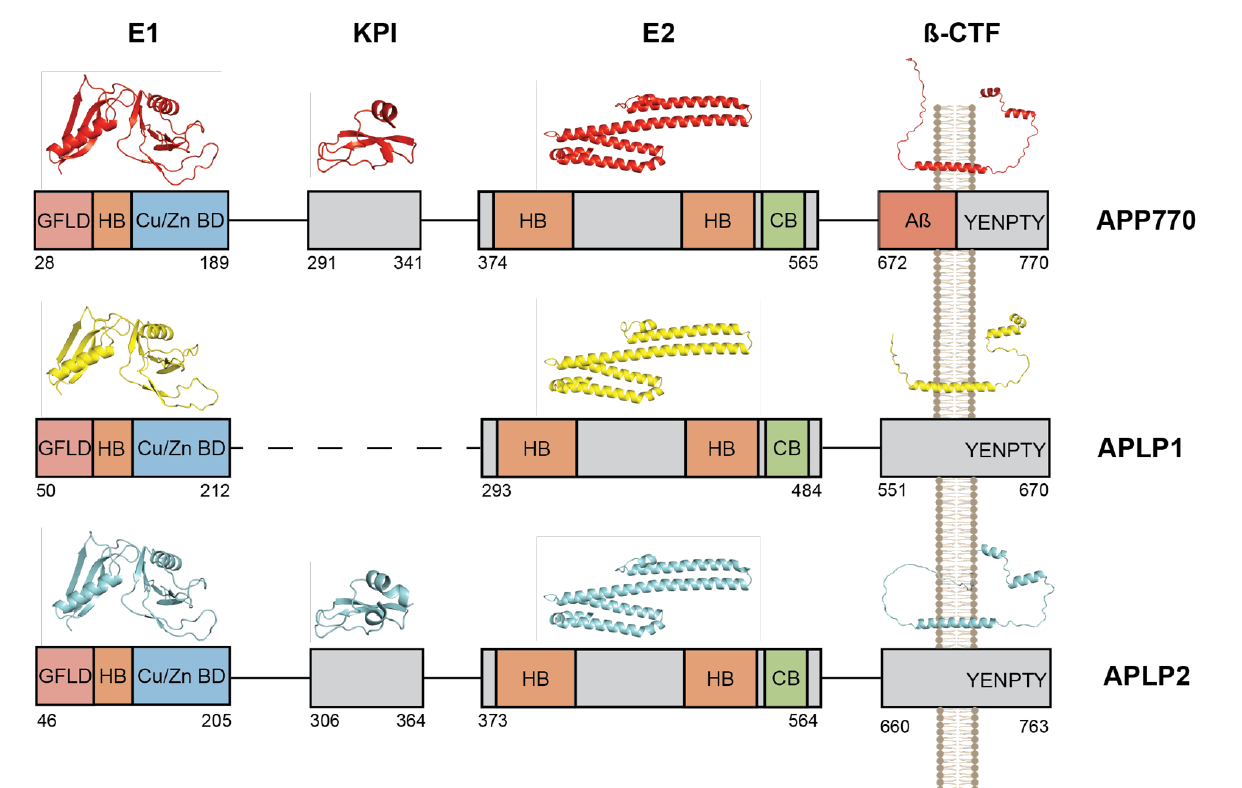
Figure 1. Structure of the APP proteins family. Structure of the APP and APLPs proteins predicted by AlphaFold 2.0 [34]. The structure of folded domains of each protein are shown as red, yellow, and blue for APP 770 , APLP1 , and APLP2 , respectively. Unstructured regions are not shown. The domains corresponding to each structure are detailed with amino acid numbering equivalent to the start and end of each subdomain. The YENPTY motif corresponds to the internalization motif conserved in all members of the APP family. HB: Heparin Binding (orange), CB: Collagen Binding (green), Cu/Zn BD (blue): Copper/zinc Binding Domain, GLFD: Growth Factor-Like Domain.